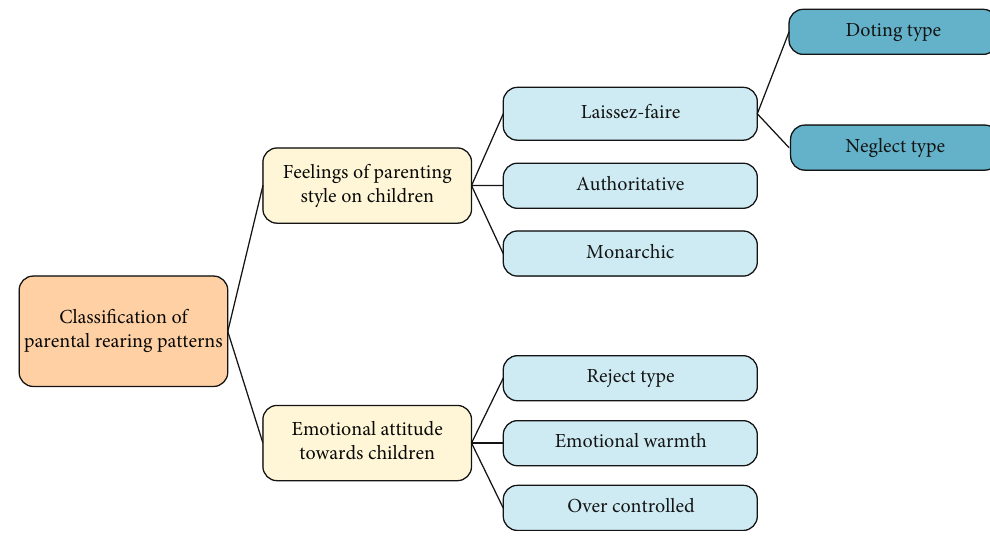
Figure 1: Classi fi cation of parenting